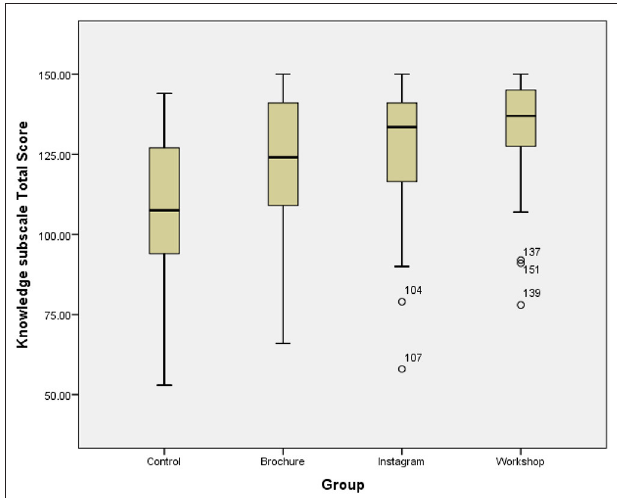
FIGURE 2 | Comparison boxplot of the total knowledge subscale score for the control group and the intervention groups.